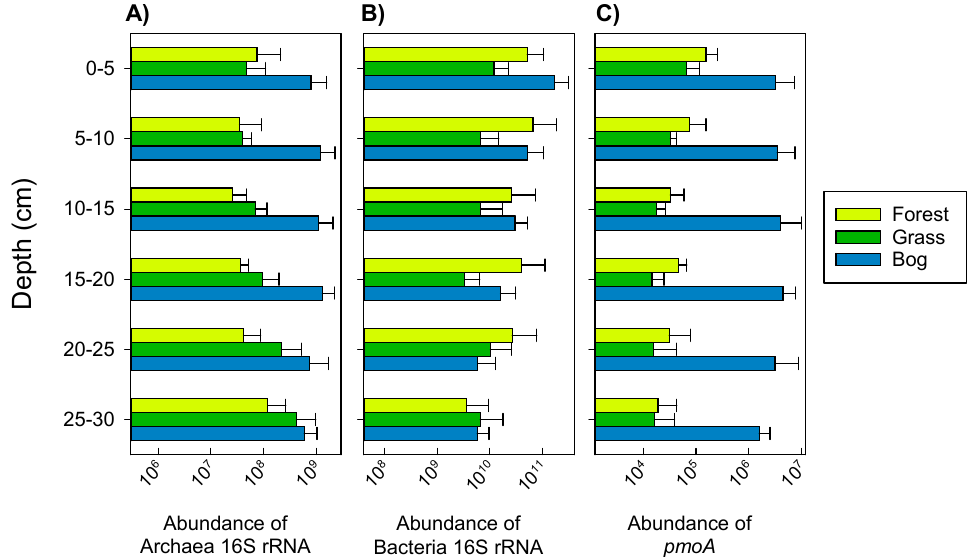
Figure 4. Abundance of archaeal ( A ) and bacterial ( B ) 16S rRNA genes, and pmoA ( C ) per g of dry soil. Means and standard error are shown ( n = 4) for all samples.